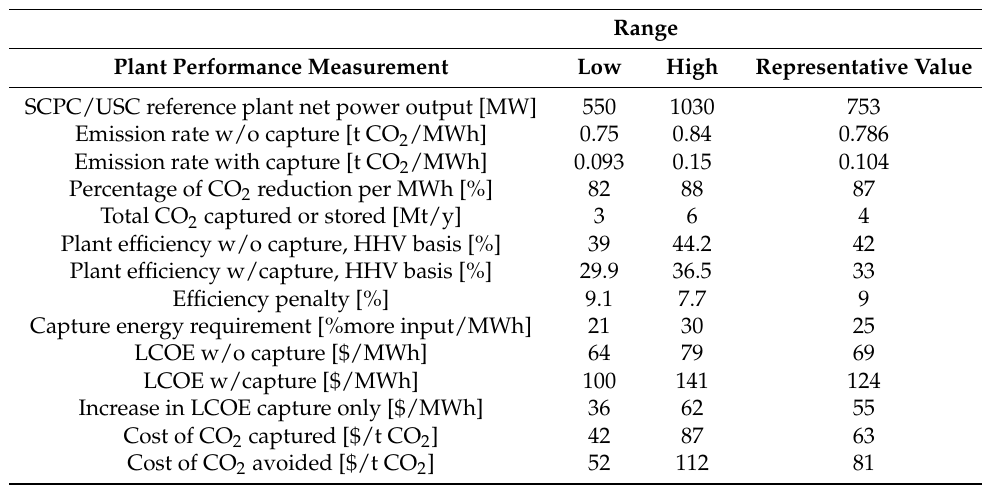
Table 2. Summary of the results of new IGCC power plants with and without a pre-combustion capture system [21].